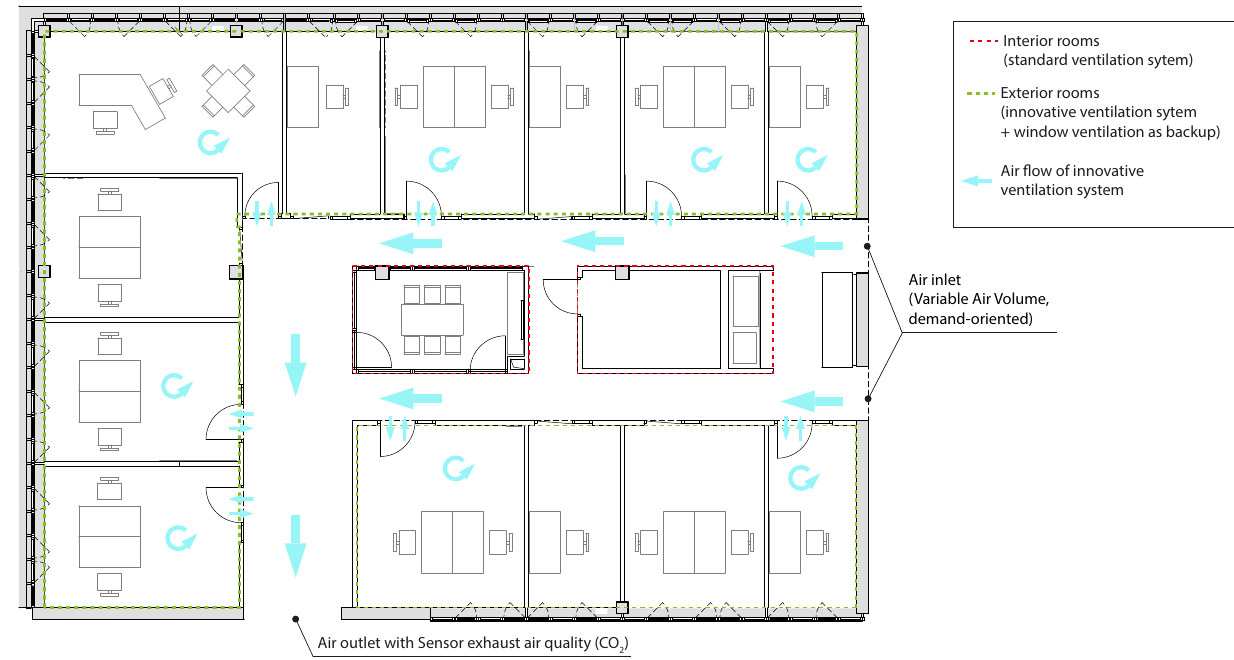
Figure 2. Scheme of innovative ventilation concept for an exemplary quadrant of the CAB, where lower-temperature air is supplied to the corridors to induce air exchange in the offices with opened